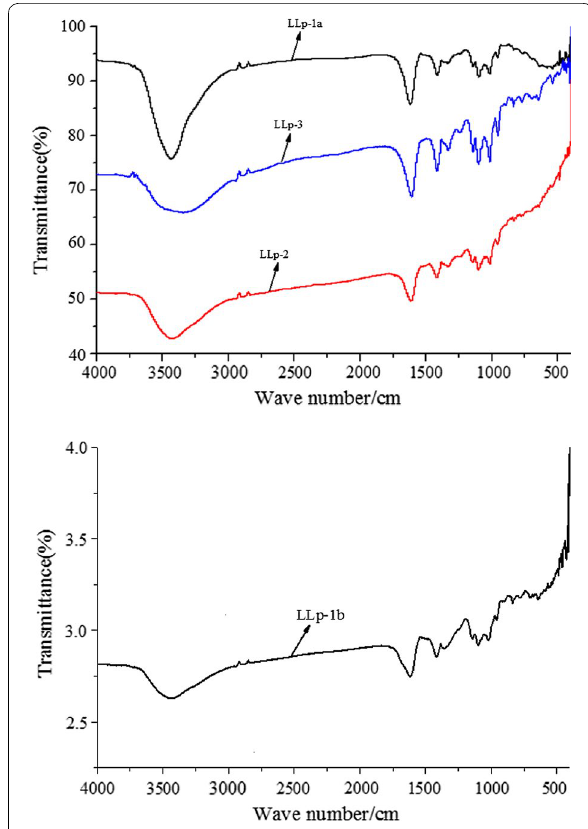
Fig. 5 FT-IR spectra of LLp-1a, LLp-1b, LLp-2 and